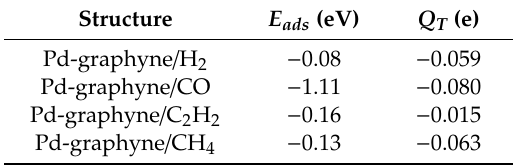
Figure 4. Optimized geometric structures of four kinds of molecule adsorbed on Pd-graphyne: ( a ) H 2 adsorption; ( b ) CO adsorption; ( c ) C 2 H 2 adsorption; ( d ) CH 4 adsorption. Table 2. Adsorption energy and electron transfer of H 2 , CO, C 2 H 2 , or CH 4 adsorbed on Pd-graphyne.